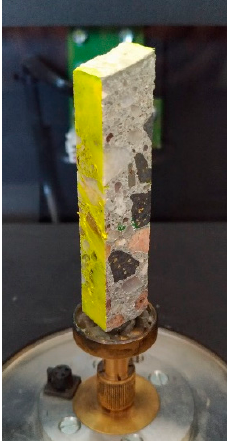
Figure 17. The sample attached to the holder and mounted in the chamber of X-ray scanner.